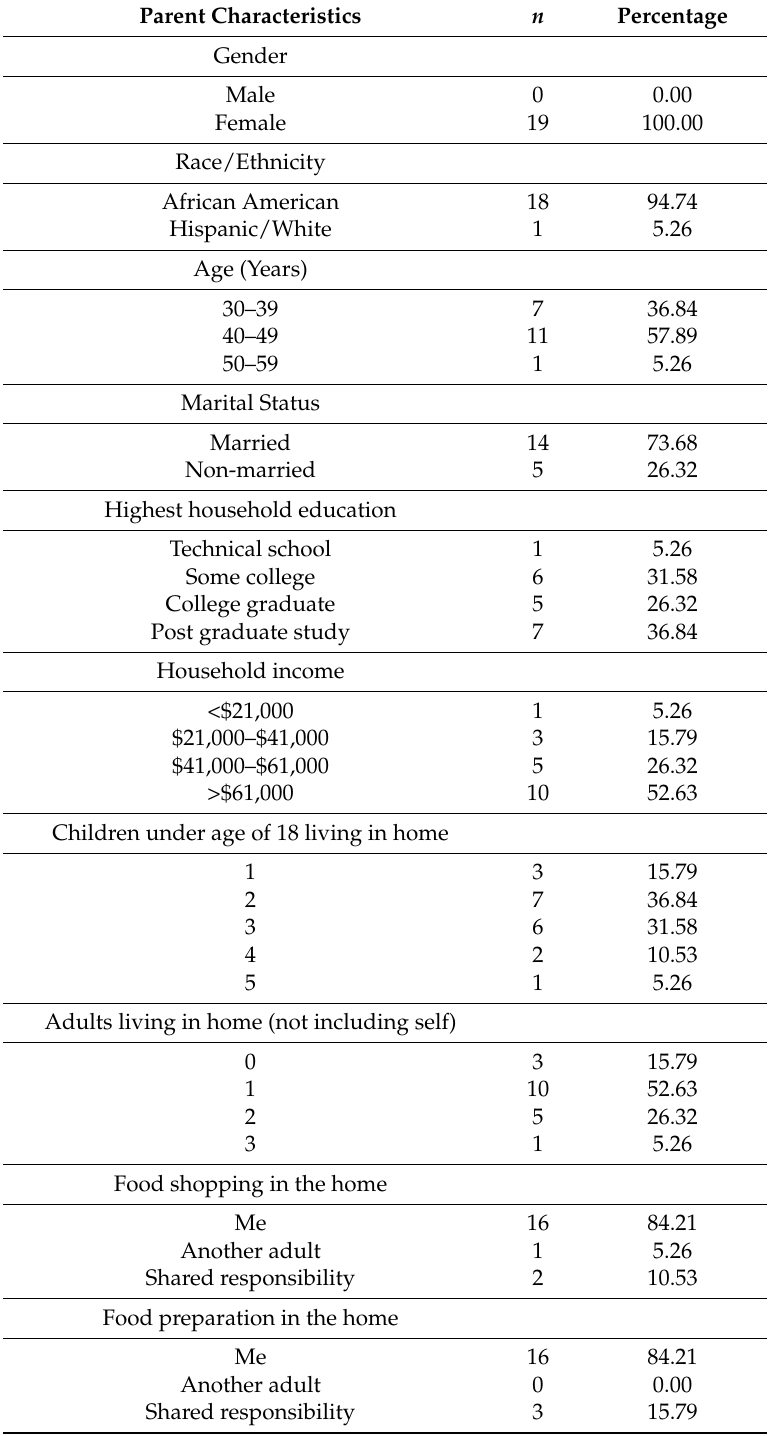
Table 1. Descriptive statistics of parent characteristics for the Family TXT Study ( n =